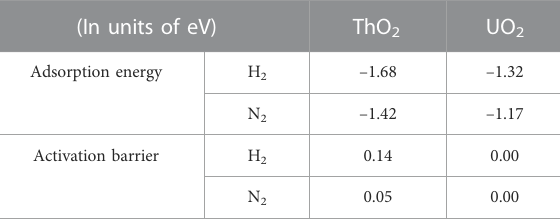
TABLE 1 Adsorption energies and activation barriers of H 2 and N 2 molecules on ThO 2 and UO 2 surfaces containing oxygen vacancies. (In units of